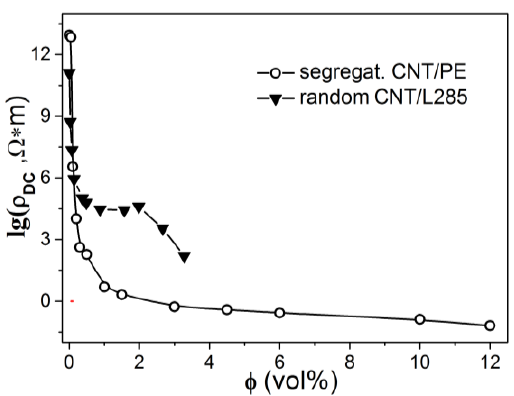
Figure 1. DC resistivity ρ DC , versus filler content for composites with segregated carbon nanotubes (CNT)/ polyethylene (PE) composites with a segregated filler distribution, and for CNT/epoxy composites with a random filler distribution for comparison.